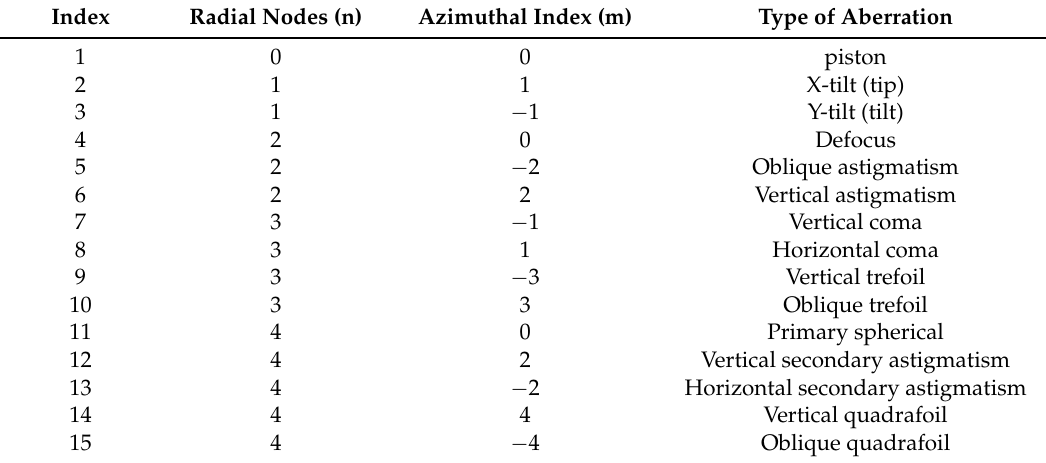
Table 1. Classification of Zernike polynomials and corresponding optical aberration. Even and odd Zernike polynomials are defined as Z m n “ R m n p ρ q cos p m φ q and Z m n “ R m n p ρ q sin p m φ q , where ρ and φ are